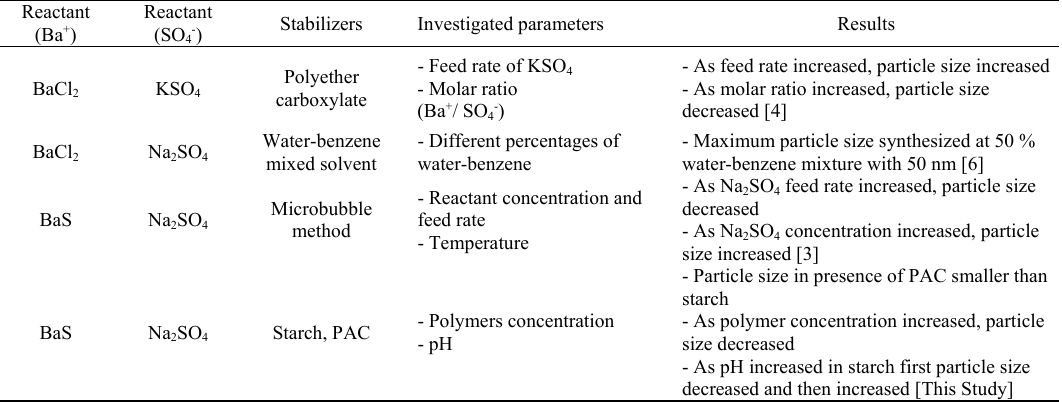
321 J Nanostruct 9(2): 316-325, Spring